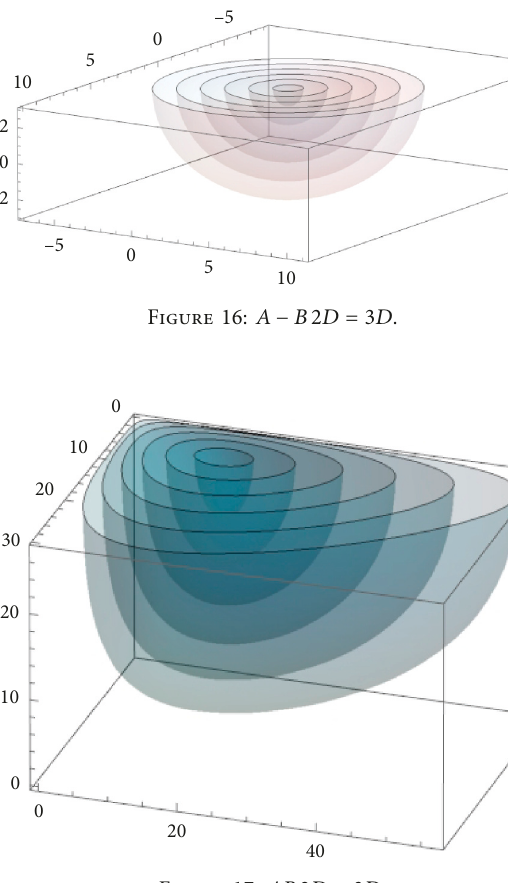
Figure 13: AB 3 Dhalf − cut .